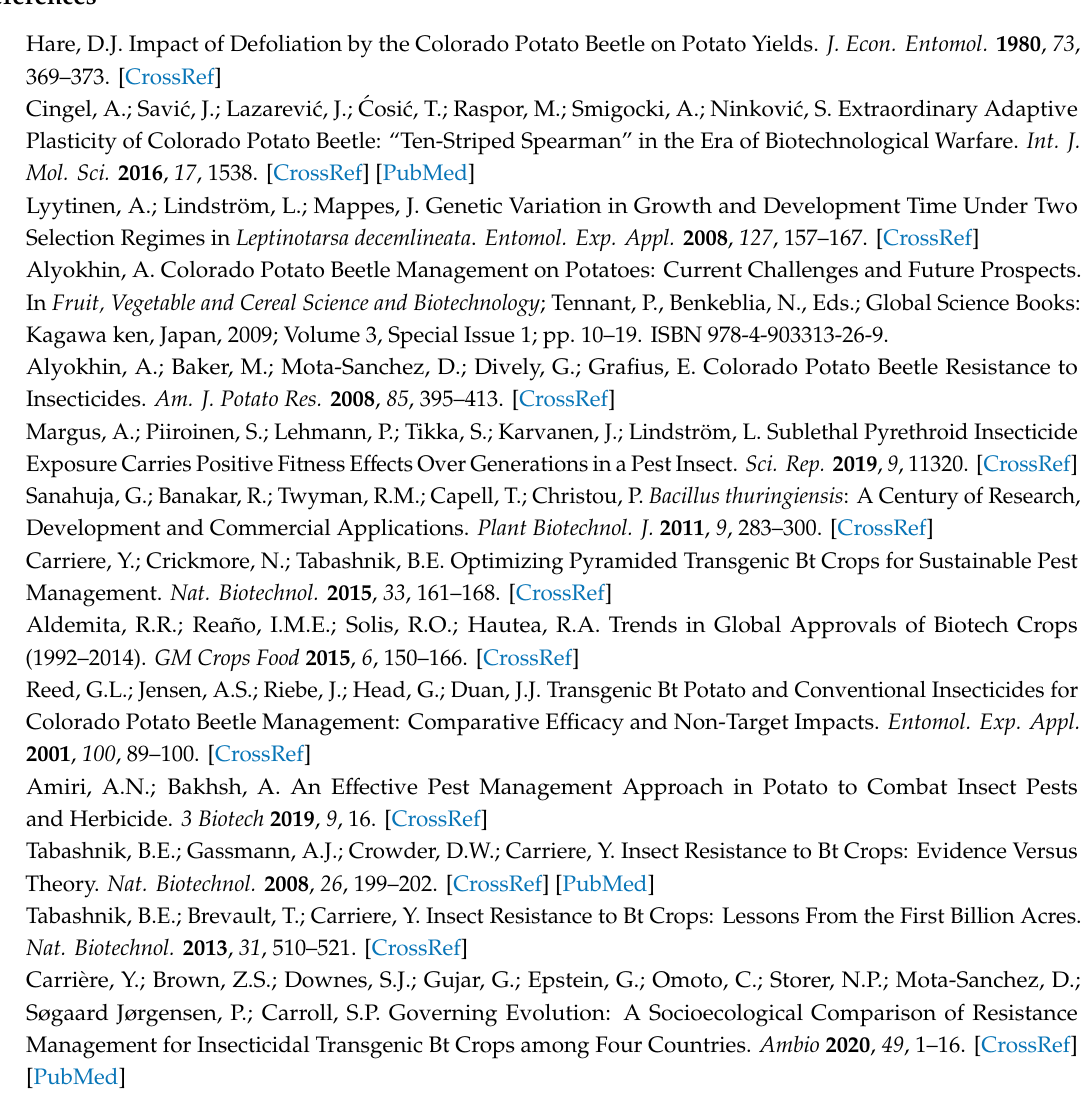
Figure S1: The relative location of potential sites were predicted to generate e ff ective siRNAs after mutation introduction to ACT 200a (ACT 200a-1 to ACT 200a-6 ), Table S1: List of oligonucleotides used in this